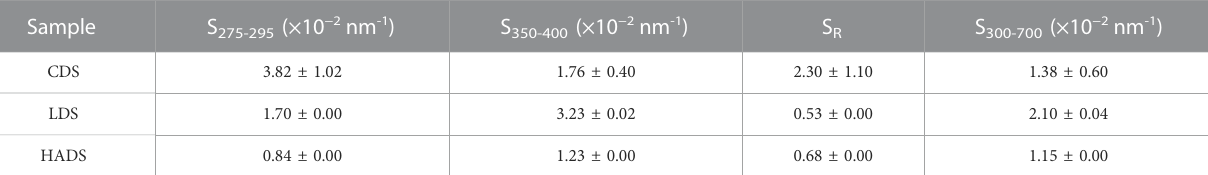
TABLE 4 Slopes derived from absorption spectra.